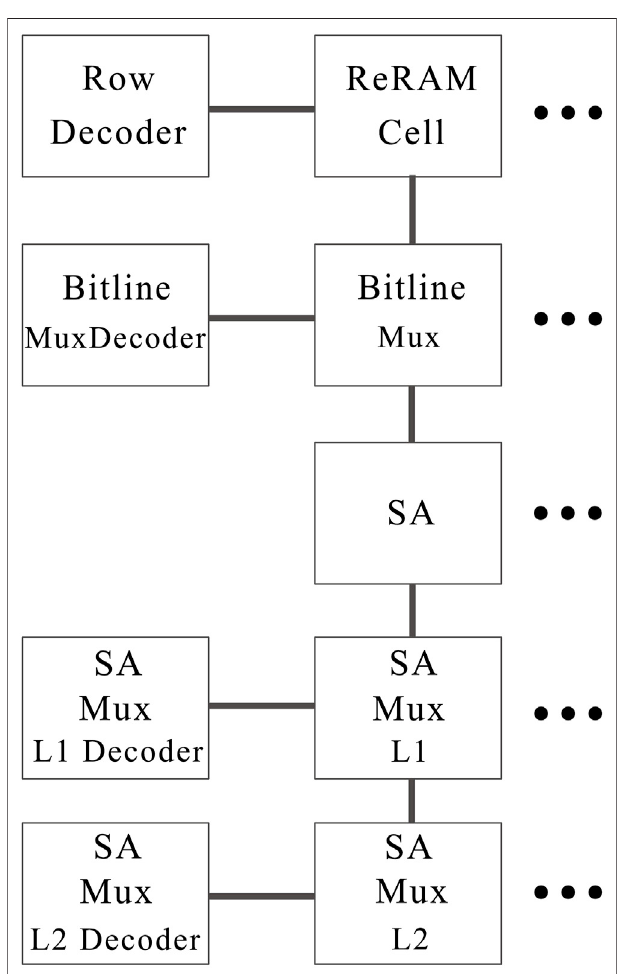
FIGURE 7 | The write path for one cell at the subarray level.